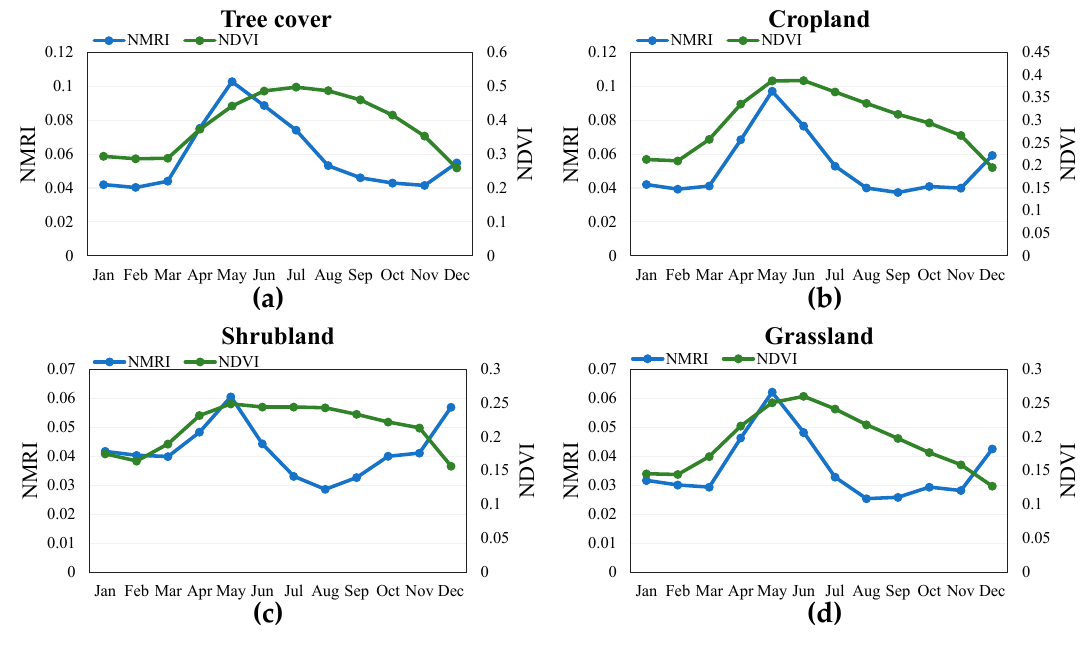
Figure 12. NMRI and NDVI long time-series variation diagrams of four Land cover types in 2012: ( a ) tree cover; ( b ) cropland; ( c ) shrubland; ( d ) grassland.